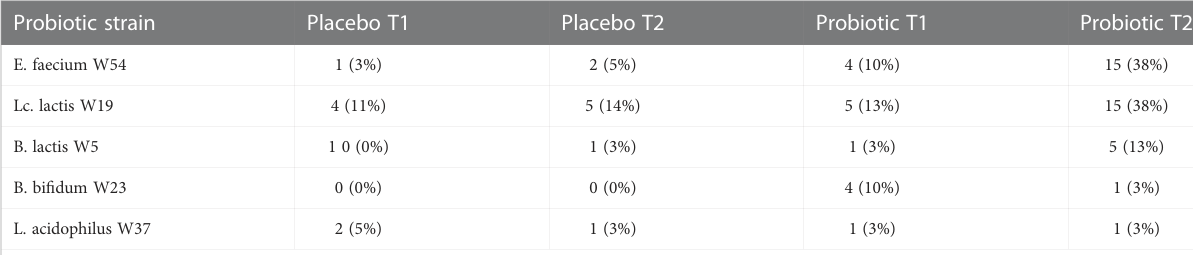
TABLE 2 Probiotic recovery in all groups and